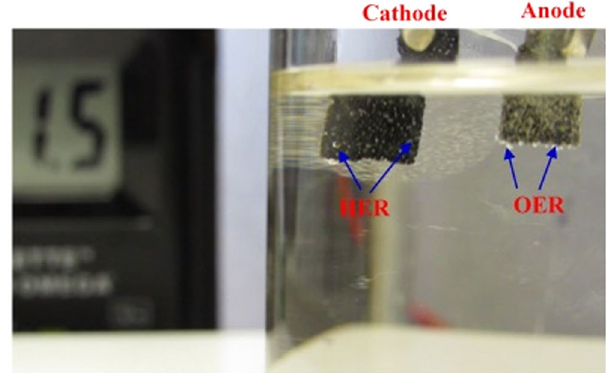
Figure 9. Demonstration of water-splitting device driven by a DC power supply at a cell voltage of 1.5 V to deliver a current density of ~6 mA cm − 2